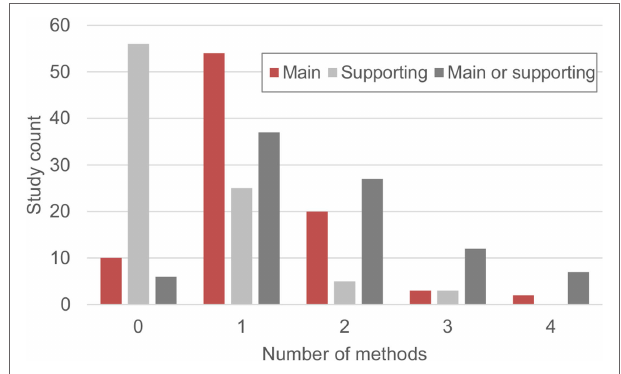
FiGURe 12 | Number of methods used per study